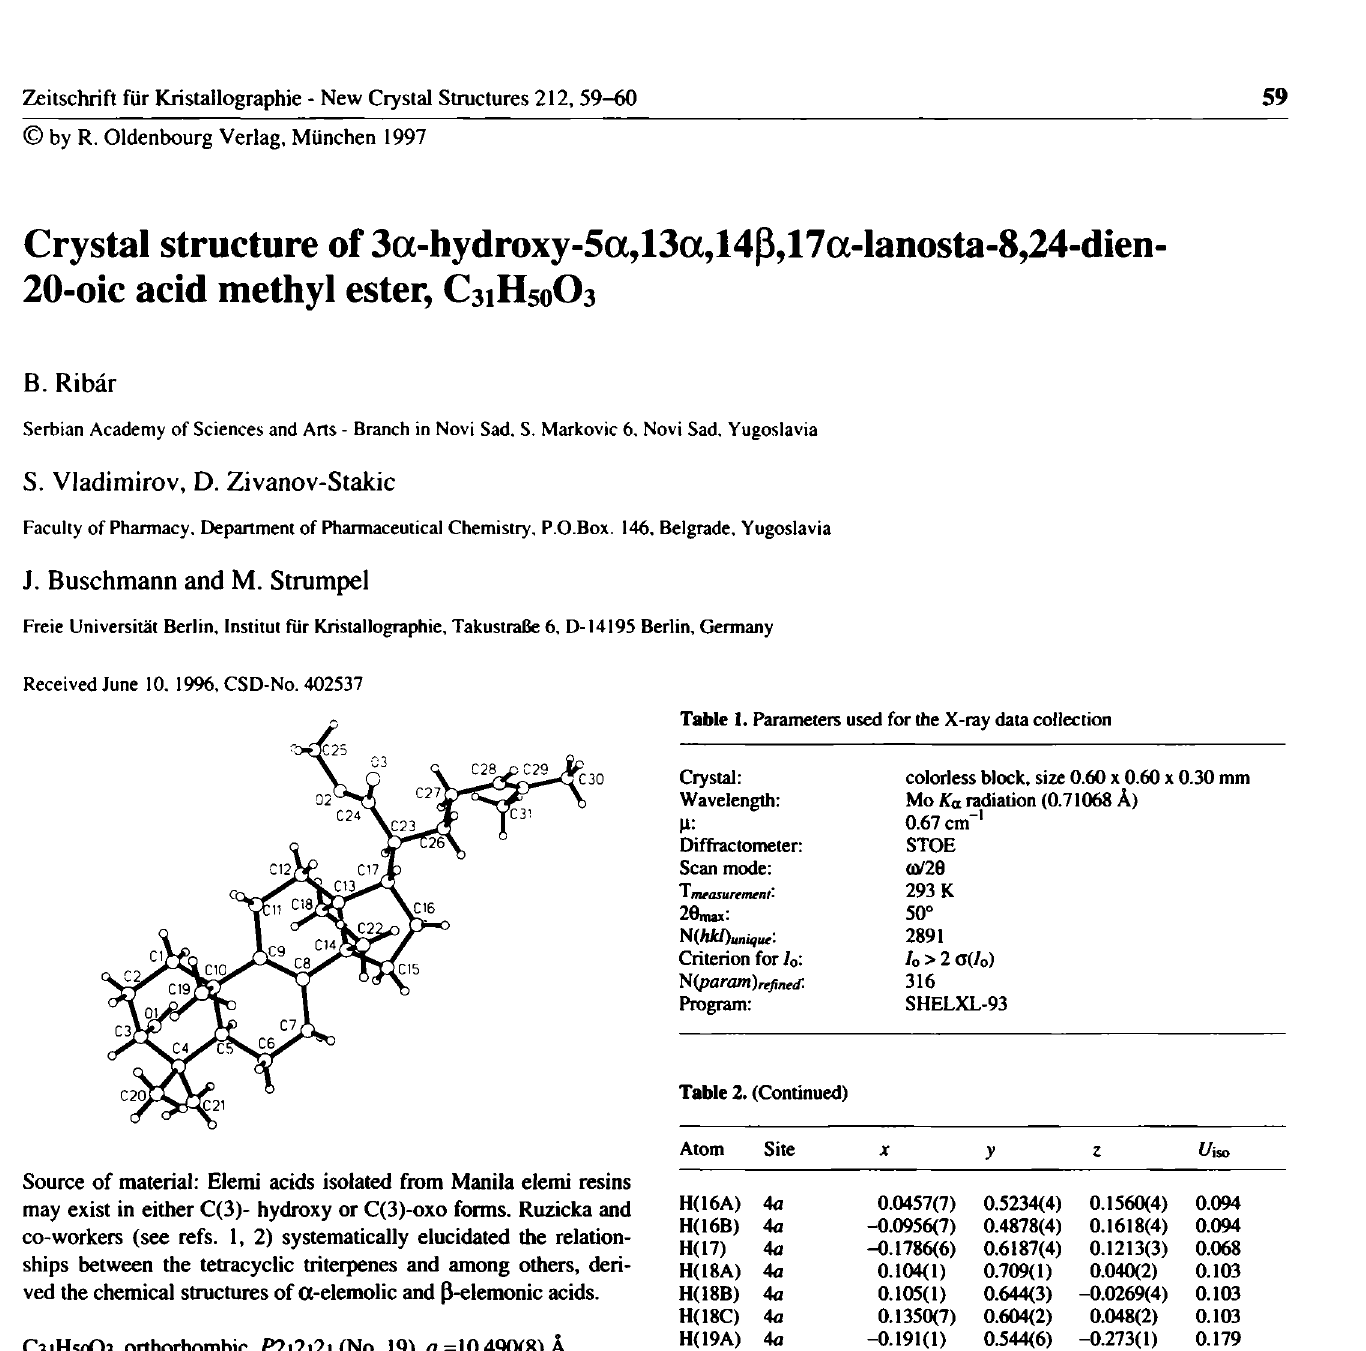
Table 2. Final atomic coordinates and displacement parameters (in Â 2 ) Atom Site